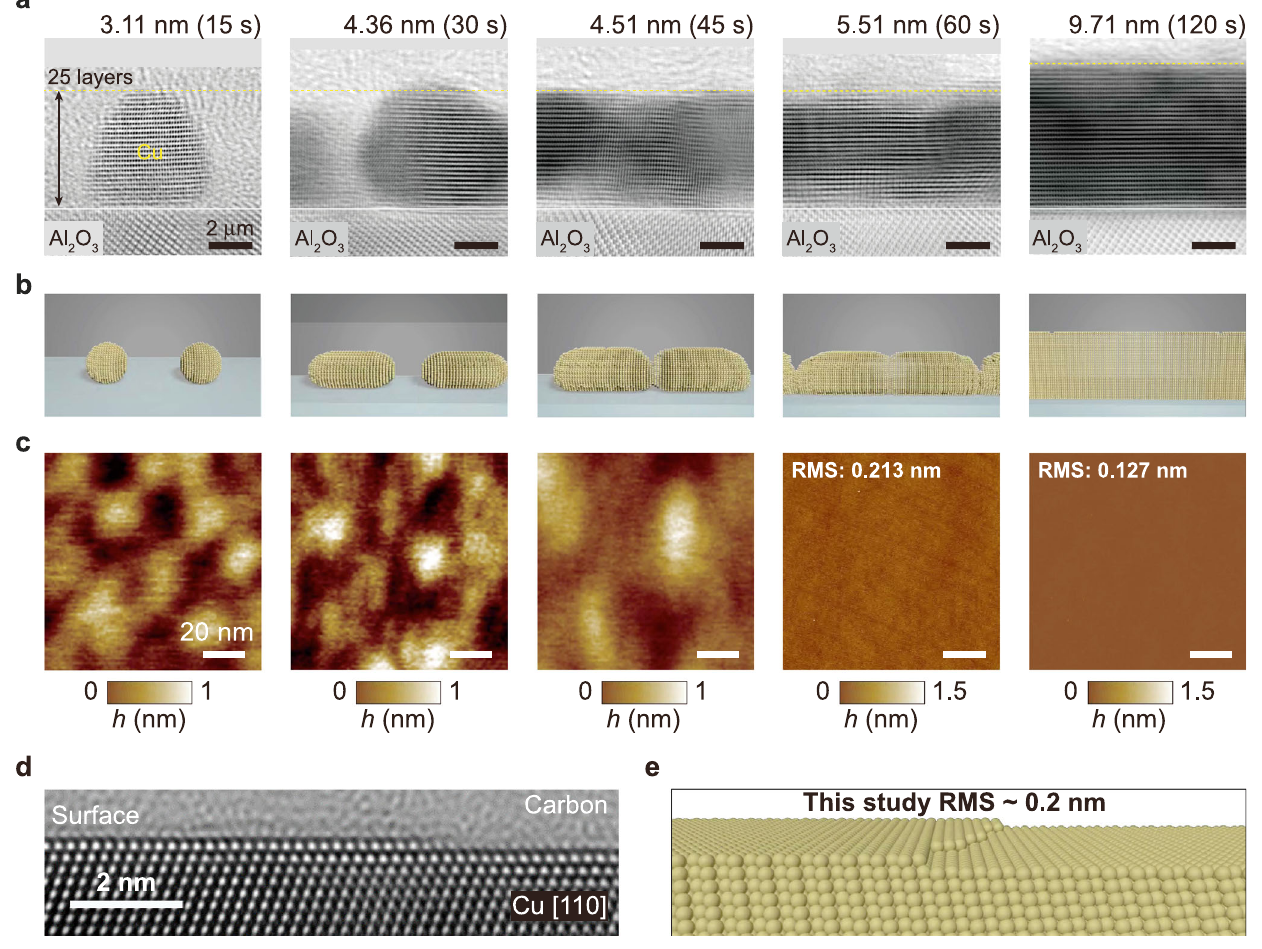
fi vedifferentthicknesses,correspondingtoinitialdepositiontimesof15,30,45,60 and 120s. d Cross-sectional high-resolution scanning transmission electron microscopy (HRTEM) image of the 12-nm-thick single-crystal Cu fi lm showing mono-atom step-level fl at surfaces (MSFS) with a root-mean-square (RMS) rough- ness of ~0.2nm. e Schematic side view of MSFS in d